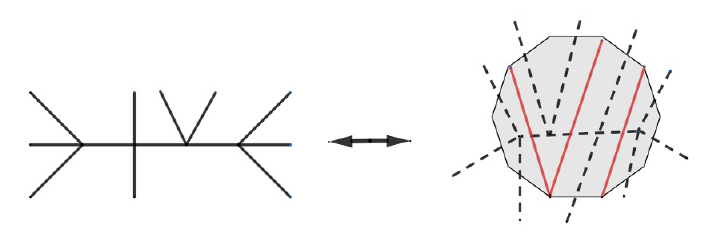
Figure 7 . A one-to-one correspondence between Feynman graphs of φ 4 theory and quadrangula- tions of an even polygon.